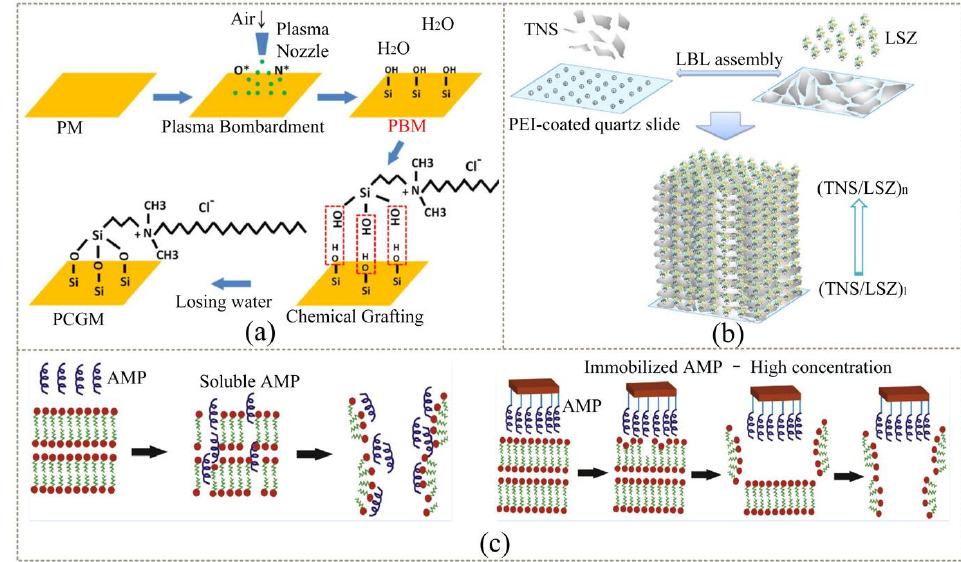
Figure 8. Preparation process and bactericidal mechanism of contact-type antibacterial coatings: ( a ) preparation of a glass-fiber membrane modified by QASs [101]; ( b ) schematic illustration of the procedure for fabricating the TiO 2 nanosheets (TNS)/lysozyme (LSZ) multilayer composite film [125]; ( c ) mechanism of action of immobilized CM against bacterial membranes [126].